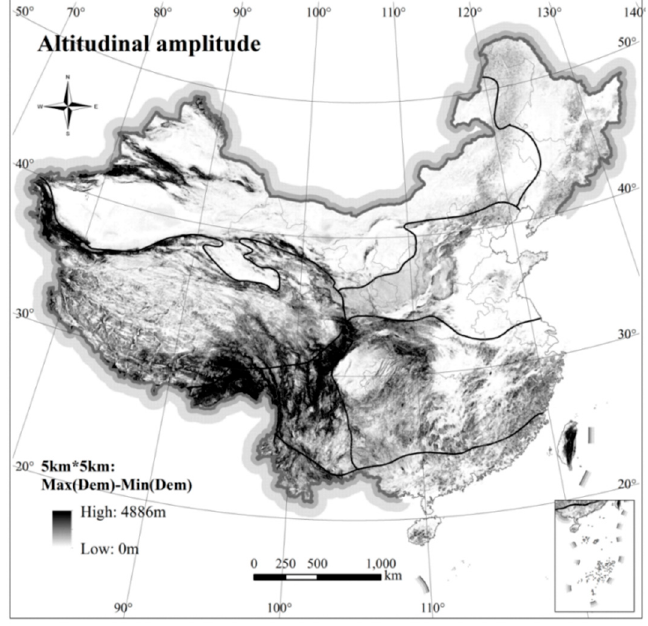
Figure 7. Spatial distribution of altitudinal amplitude in China.